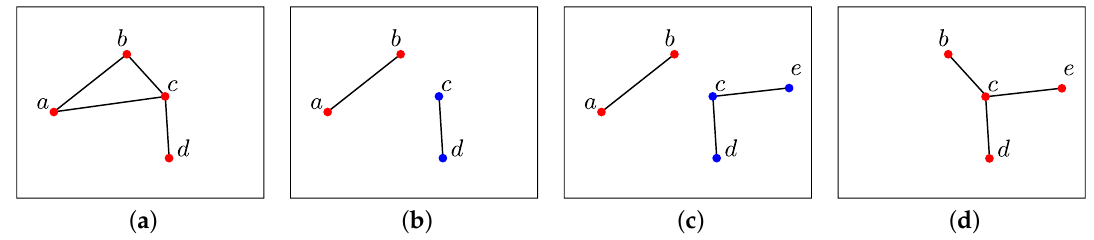
Figure 1. The result of tracking objects in a graph at four consecutive discrete times using the proposed method is illustrated where each vertex is labelled with a unique letter. In this case, individual objects correspond to connected components of the graph where the same object existing at multiple consecutive discrete times is represented using a single unique vertex